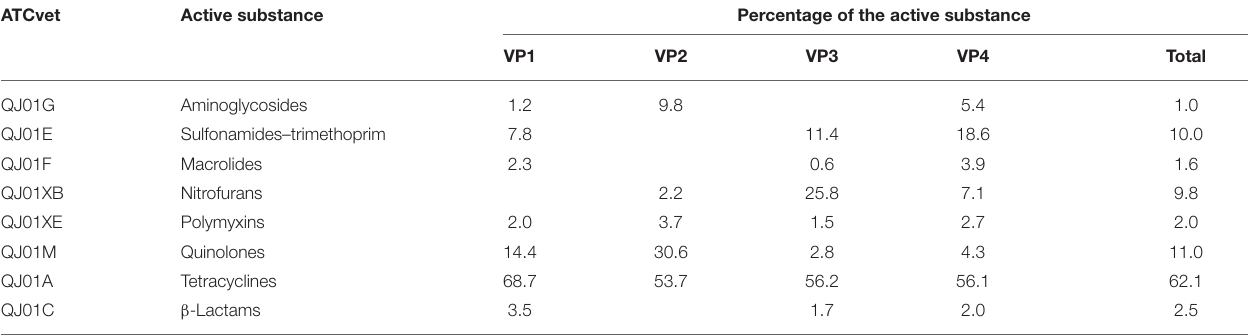
TABLE 2 | Percentage of the total amount of most important antimicrobial classes sold in four ( n = 4) veterinary pharmacies in the West Region of Cameroon in 2011. ATCvet